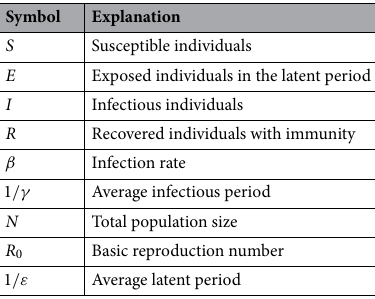
Table 1. Notation of the SEIR